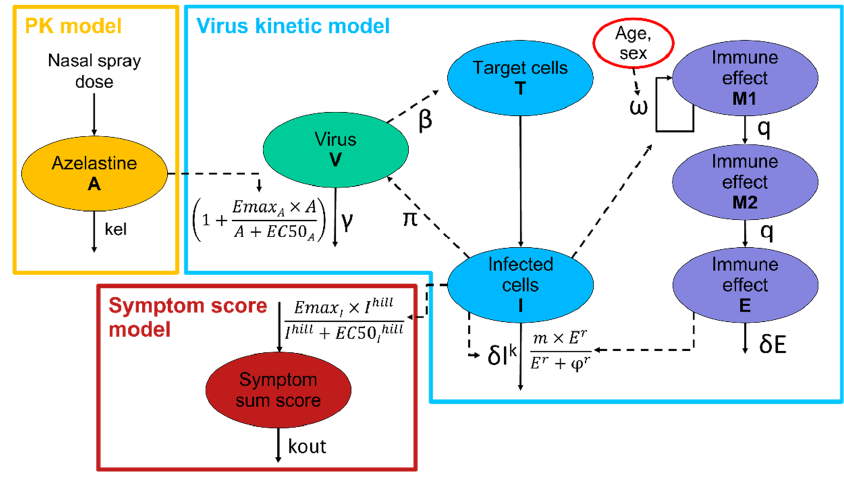
Figure 1. Schematic representation of the final PK ‐ virus kinetic ‐ symptom score model. The PK model is represented in yellow. Different parts of the virus kinetic model are represented in green, blue and violet. The symptom score model is represented in red.